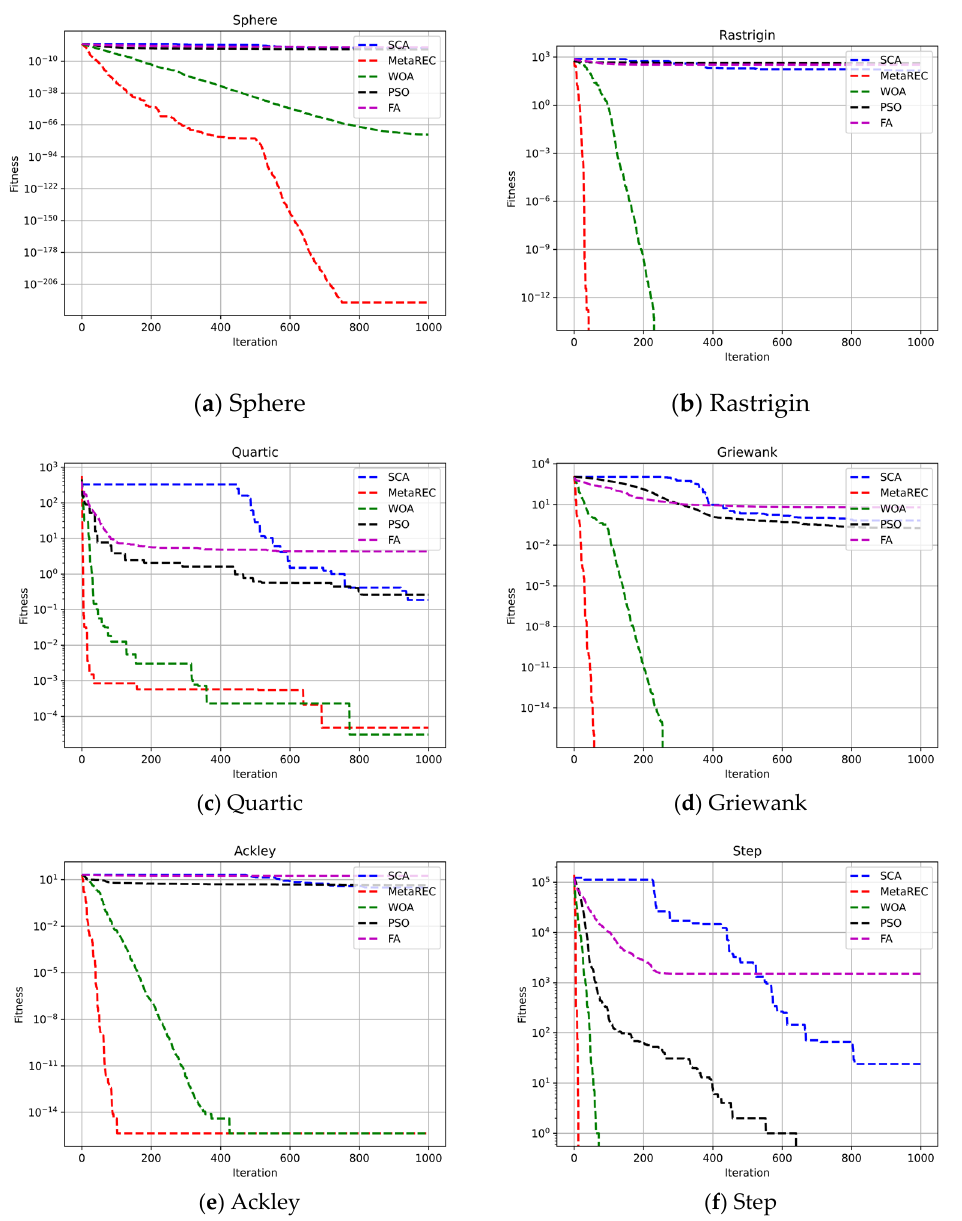
Figure 8. Comparison of the convergence of the SCA, PSO, FA, WOA, and MetaREC on test functions. ( D = 50 )